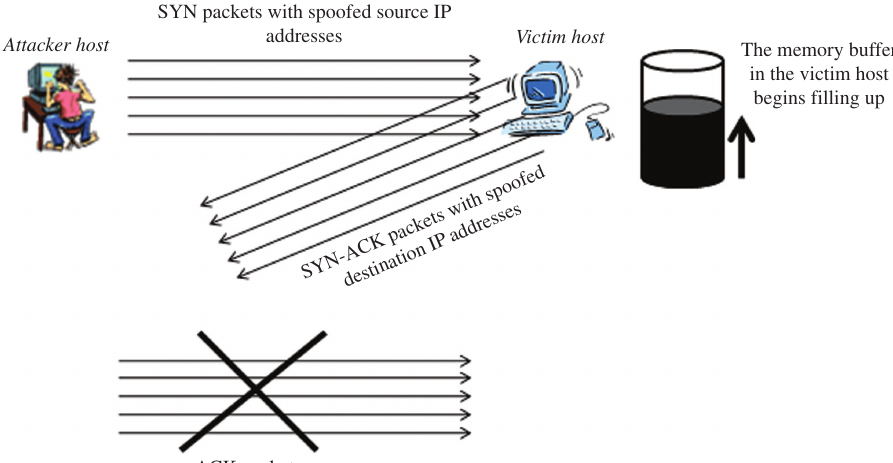
Figure 2. The SYN Flood